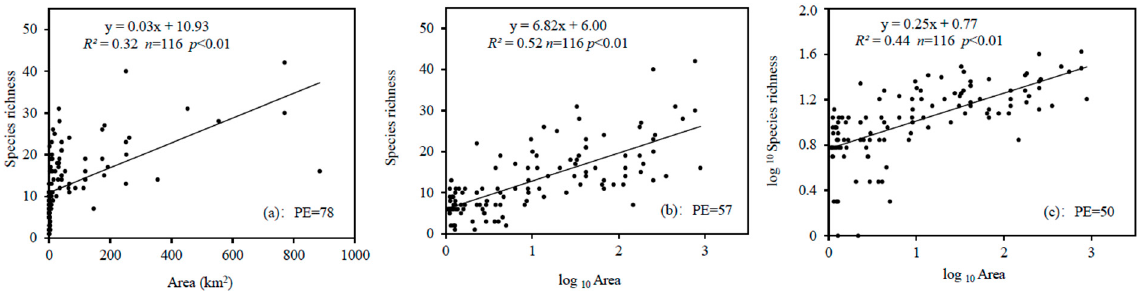
Figure 1. Species–area models for macrobenthos in shallow lakes of the mid-lower Yangtze River Basin. ( a ) linear regression ( S / A ), ( b ) semi-log model ( S /log 10 A ), and ( c ) power model (log 10 S /log 10 A ).